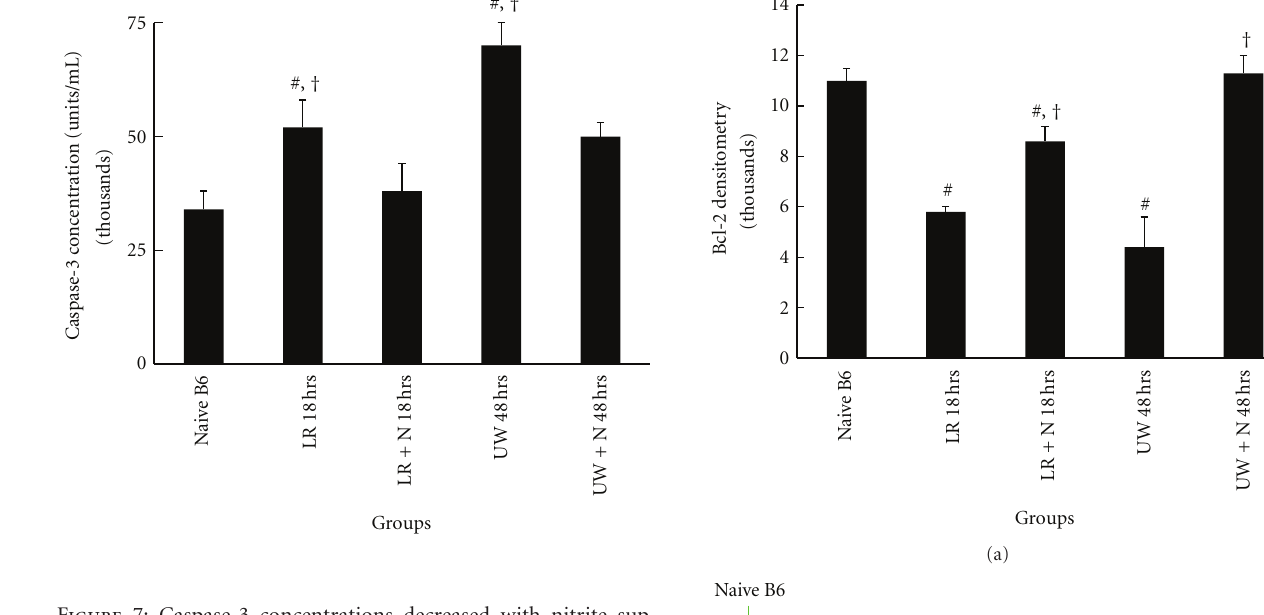
Figure 7: Caspase-3 concentrations decreased with nitrite sup- plemented solutions. Caspase-3 concentrations increased during cold preservation with both LR (18 hours) and UW solutions (48 hours) alone, but were significantly attenuated when the respective solutions were supplemented with 250 µ M of anion nitrite (LR— 49 . 1 ± 3 . 7 versus LR + nitrite—38 . 6 ± 3 . 7; UW—71 . 4 ± 4 versus UW + nitrite 50 . 4 ± 3 . 1). Supplemented UW solution demonstrated the greatest attenuation. Data are expressed as mean ± SE. # P < 0 . 05 for corresponding measurements that compared groups LR and UW only to native B6 and † P < 0 . 05 for corresponding measurements that compared groups LR and UW only to LR and UW groups treated with anion nitrite.